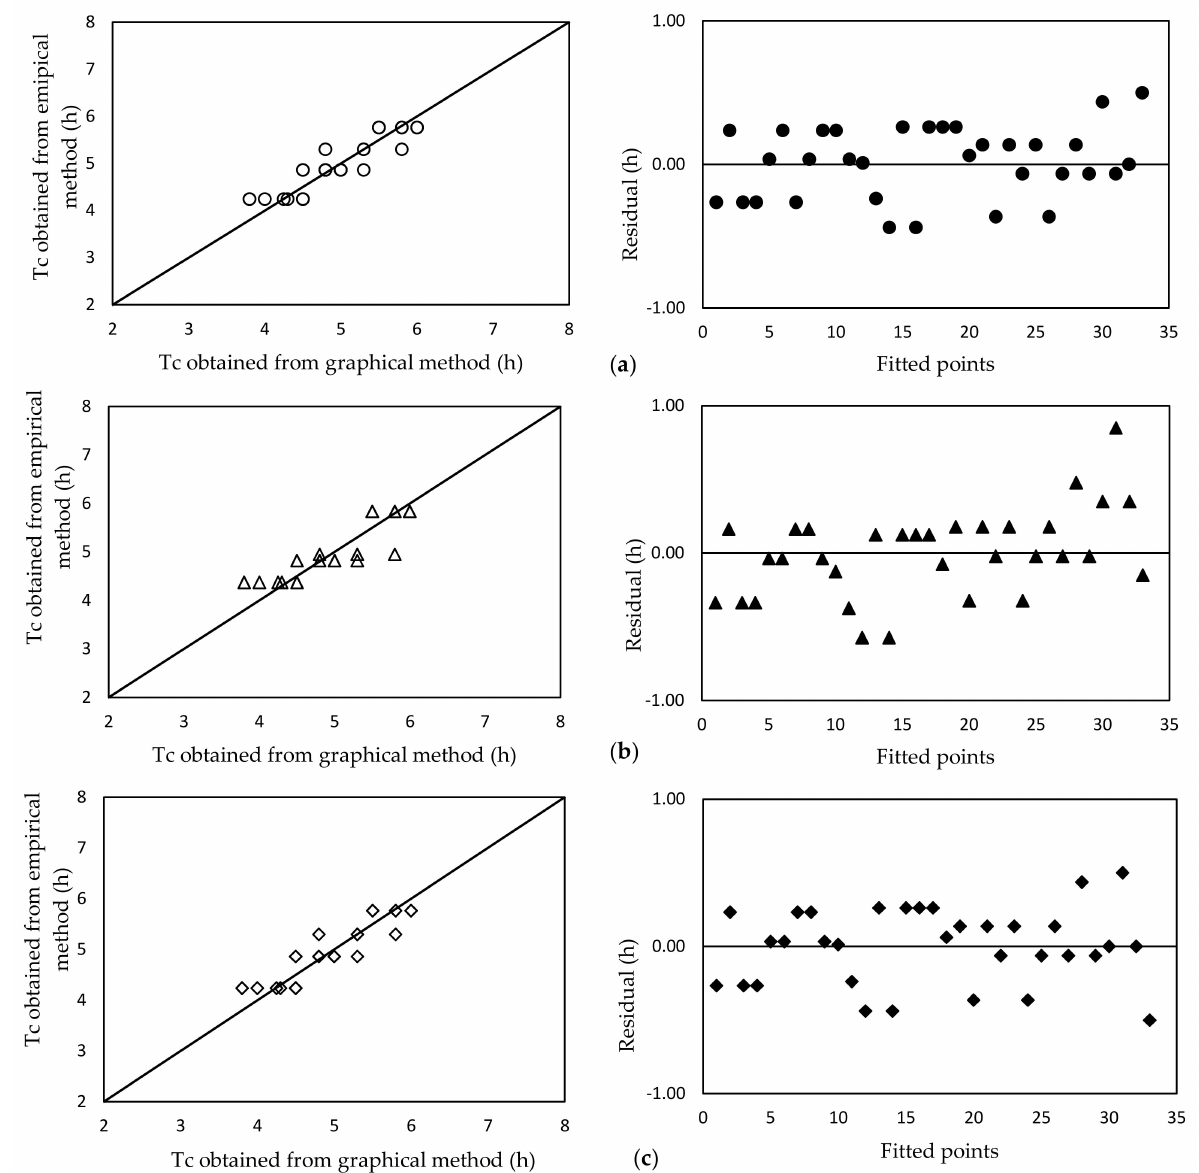
Figure 6. Tc Estimated by the modified empirical equations versus T C calculated by the graphical method and corresponding residual distribution: ( a ) modified Williams; ( b ) modified Pilgrim and Mac Dermott; ( c ) modified Arizona